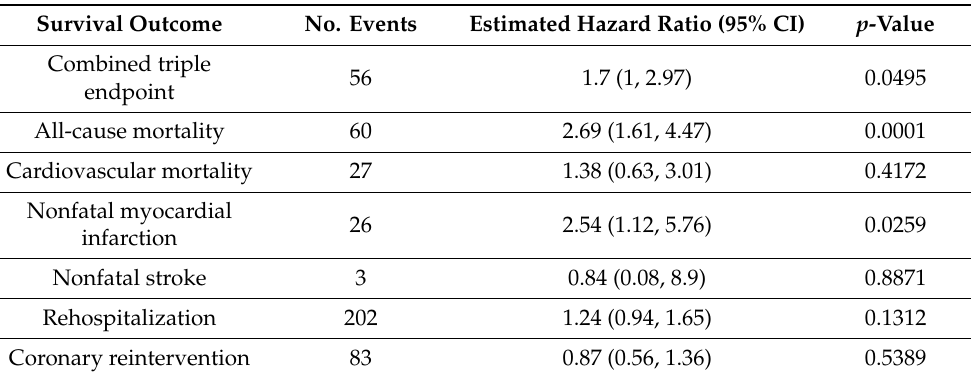
Table 2. Univariable Cox regression for log (PYY).